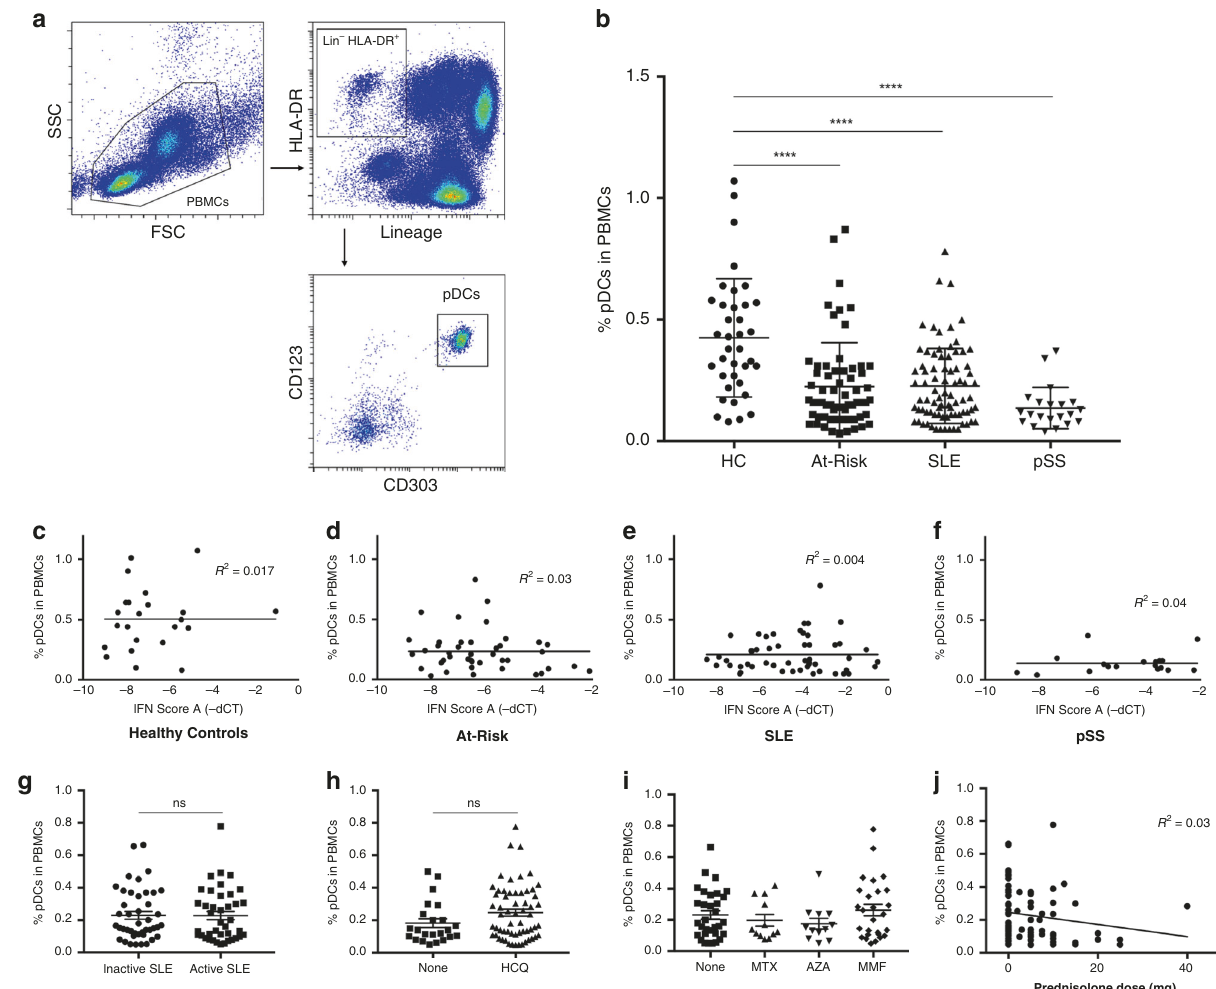
Fig. 1 Decrease in circulating pDCs in autoimmunity is independent of disease activity and therapy. a Gating strategy to identify the pDC population within PBMCs: pDCs are characterized by the lack of expression of lineage markers (CD3, CD19, CD56, CD14, CD11c), intermediate to high expression of HLA-DR, high expression of CD123 (IL-3R) and CD303 (BDCA-2). b Average percentage of pDCs in PBMCs of age- and sex-matched healthy controls (HC; n = 37), At-Risk individuals (At-Risk; n = 64), patients with systemic lupus erythematosus (SLE; n = 81) and primary Sjögren ’ s Syndrome (pSS; n = 21). c – f Association between the percentage of pDCs in PBMCs and type I IFN activity in the blood (IFN score A) in HC, At-Risk, SLE, and pSS. g Percentage of pDCs in PBMCs in SLE patients with inactive and active disease. h Percentage of pDCs in PBMCs in SLE patients treated with or without hydroxychloroquine (HCQ). i Percentage of pDCs in PBMCs in SLE patients treated with other immunosuppressants (MTX = methotrexate, AZA = azathioprine, MMF = mycophenolate mofetil). j Association between the percentage of pDCs in PBMCs and the dose of prednisolone in patients with SLE. Data are represented as mean ± SEM. ns = not signi fi cant; **** P < 0.0001. Two-way ANOVA ( b ), nonlinear regression ( c – f and j ), unpaired two-tailed t -test ( g – i